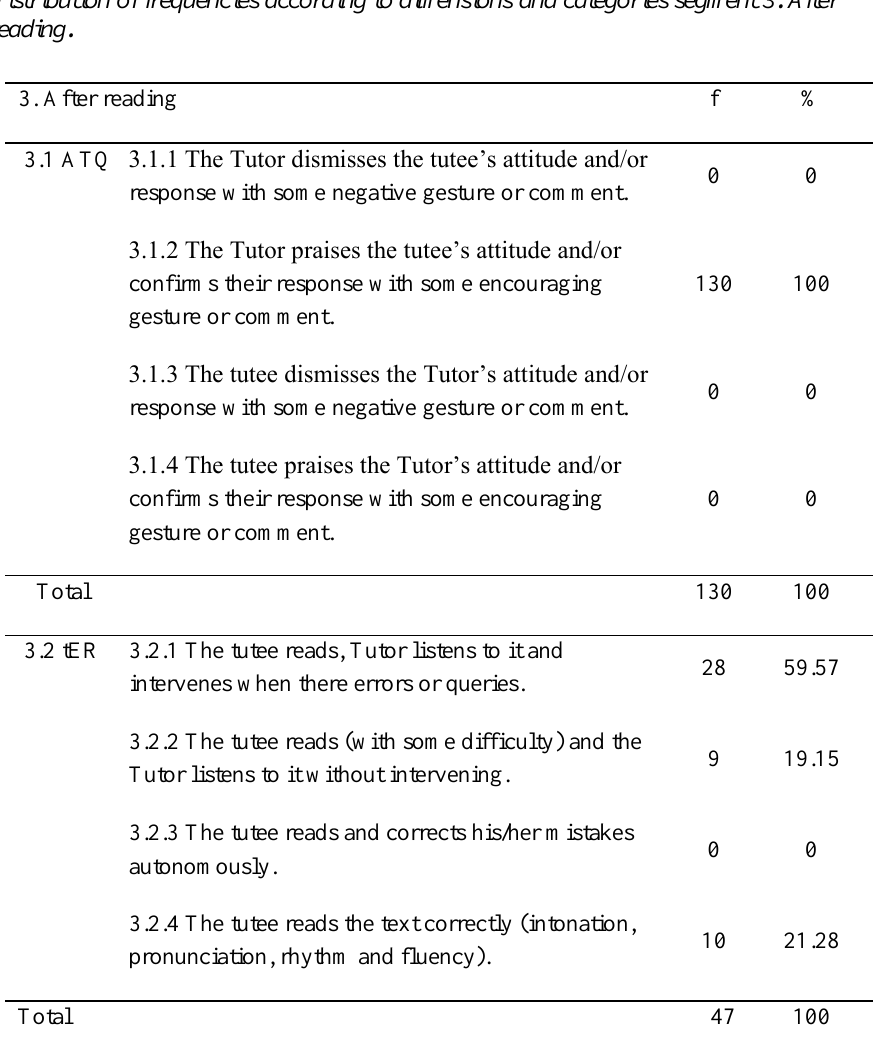
Distribution of frequencies according to dimensions and categories segment 3. After